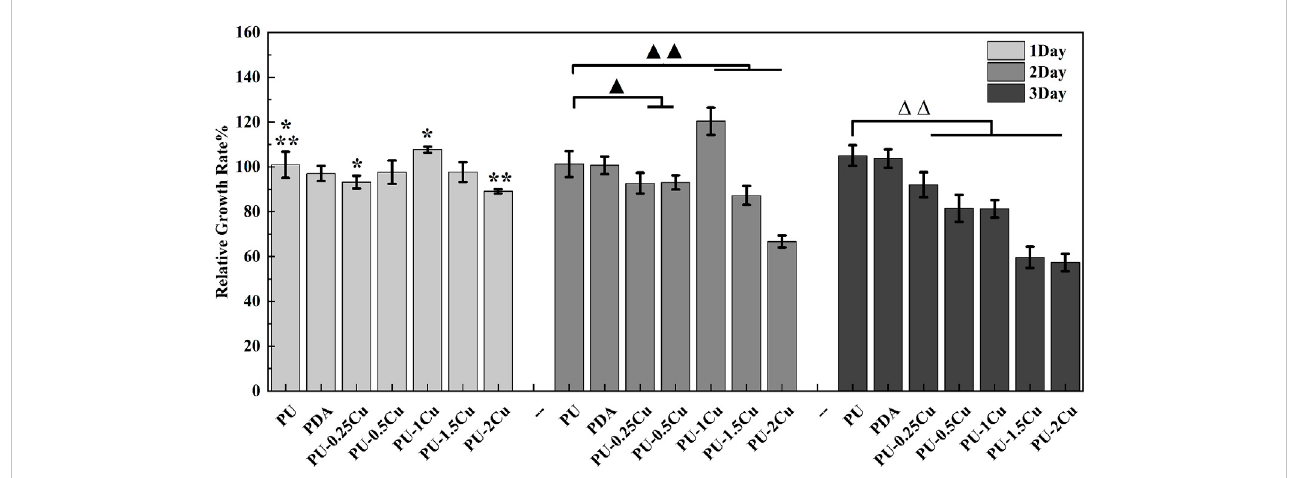
RGR of RAW264.7 cultured with the extracts for 24, 48, and 72 h. Signi fi cant differences are marked as *p < 0.05 , ▲ p < 0.05 , **p < 0.01 , ▲▲ p < 0.01 , and ΔΔ p < 0.01 , respectively.